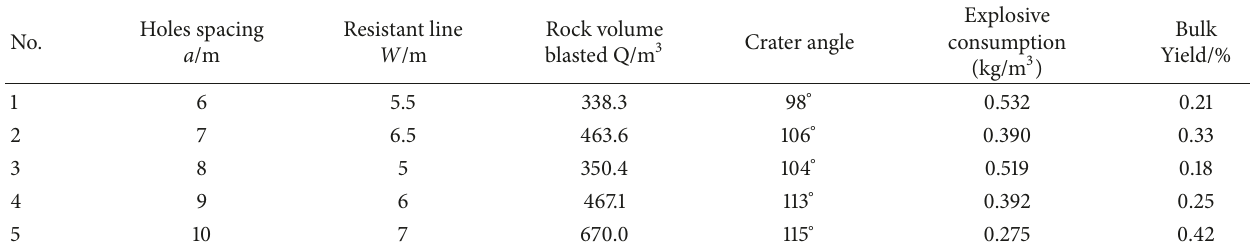
Table 3: Experiment results.